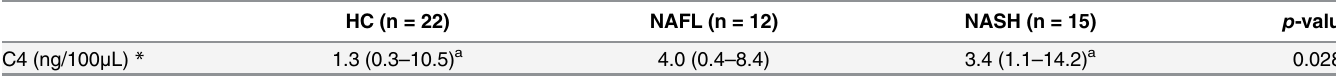
Table 4. Serum C4 in the study population ( n =